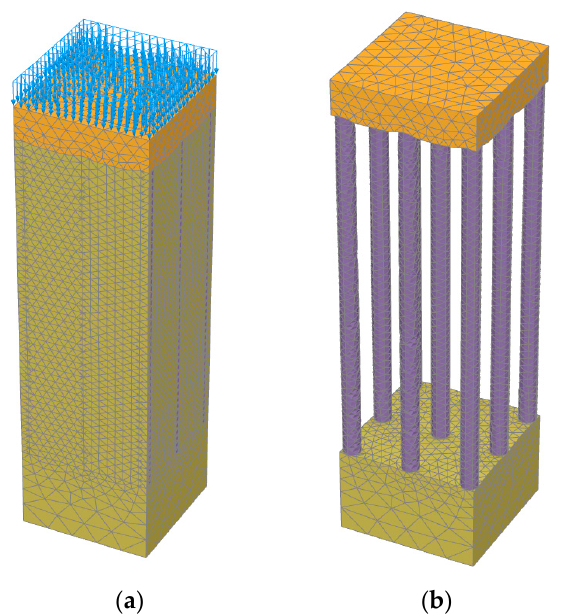
Figure 9. General model views ( a ) Finite Element Method (FEM) for verification: full model view; ( b ) FEM for verification: pile distribution detail view.